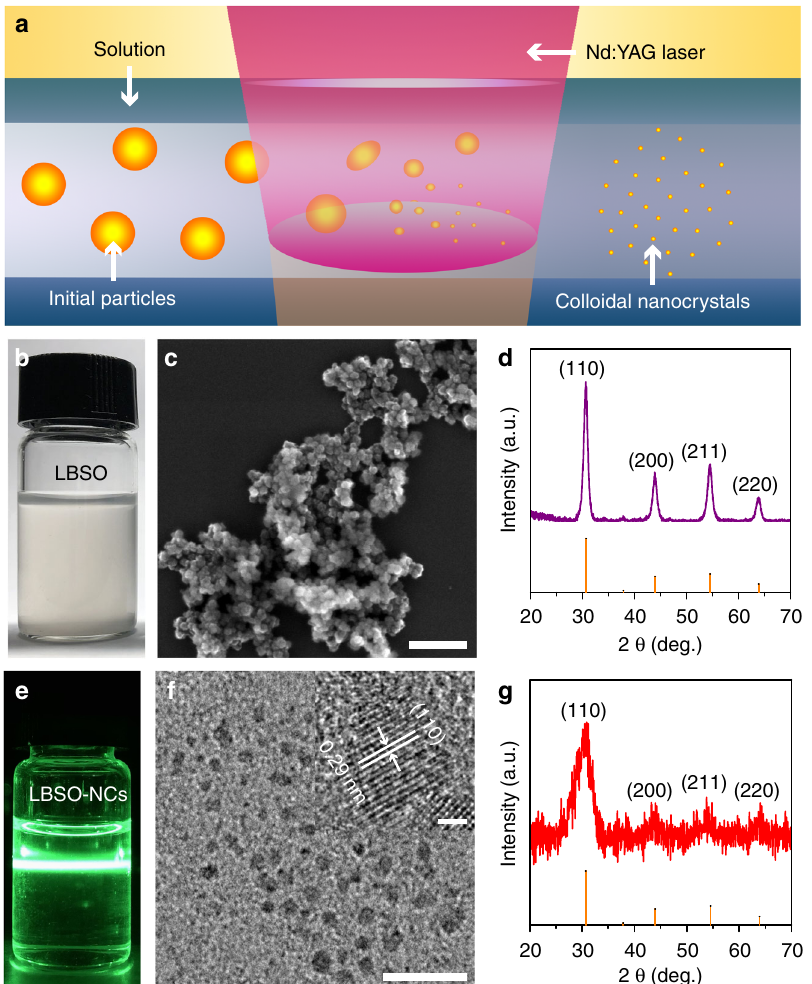
Fig. 1 LBSO before and after LSPC. a Schematic illustration of LSPC. b Optical image of LBSO particles dispersed in the solvent before LSPC. c SEM image and d XRD pattern of LBSO particles fabricated. e Mie-scattering image of laser generated LBSO colloidal nanocrystals (LBSO-NCs). f TEM and HRTEM image (insert) of LBSO nanocrystals generated by pulsed laser irradiation. g XRD pattern of LBSO nanocrystals after pulsed laser irradiation. Scale bars: ( c ) 250 nm, ( f ) 20 nm and insert of ( f ) 2